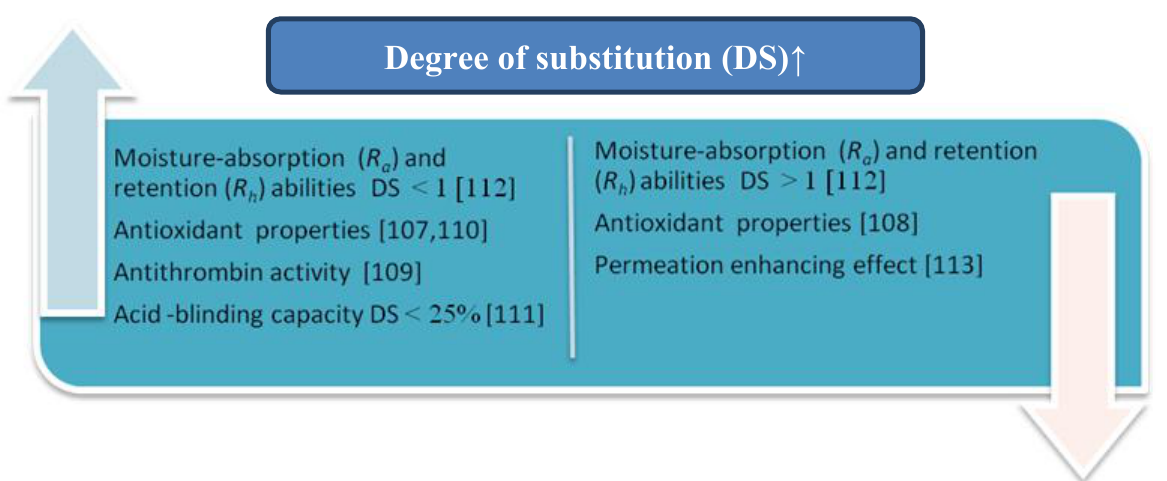
Figure 11. Influence of degree of substitution on the physicochemical and biomedical properties of chitin/chitosan-based